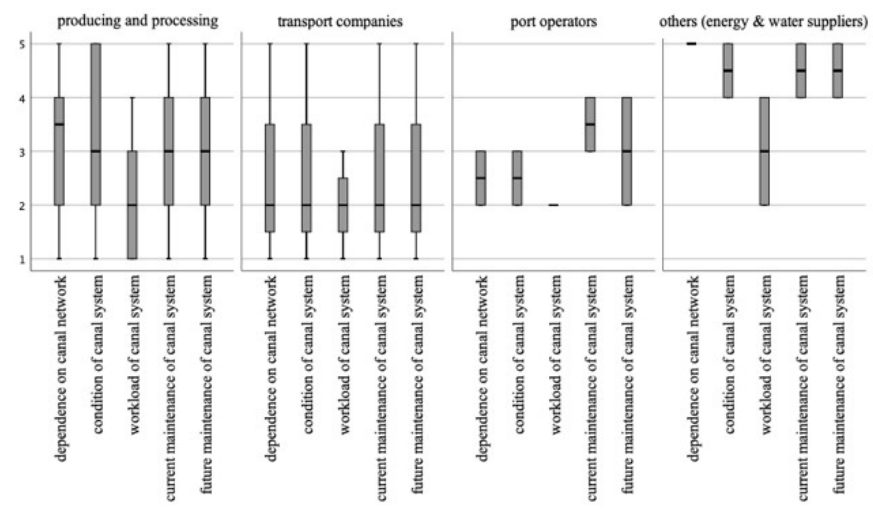
Figure 18. Risk perception depending on type of company.